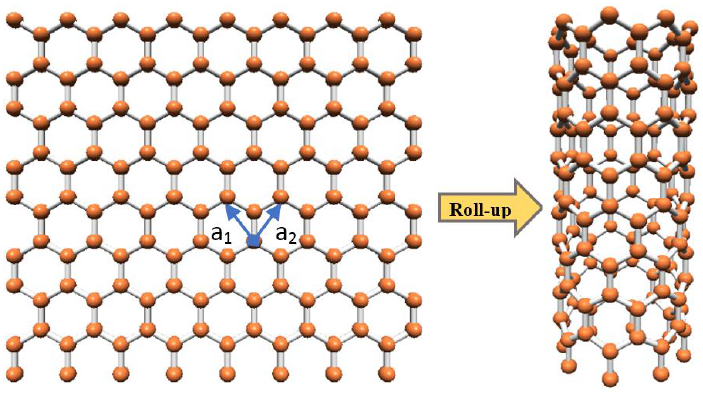
Figure 1. An SWZCNT model made up of the graphene layer.